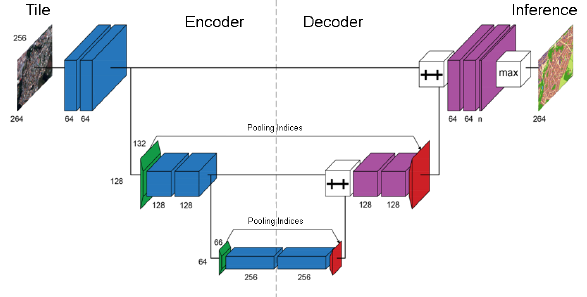
Figure 1. Proposed architecture based on Deconv-Net and U-Net. Blue : 3 × 3 convolution, green : 2 × 2 max pooling, red : 2 × 2 unpooling, Violet : 3 × 3 deconvolution, ++ : concatenation, max : softmax.